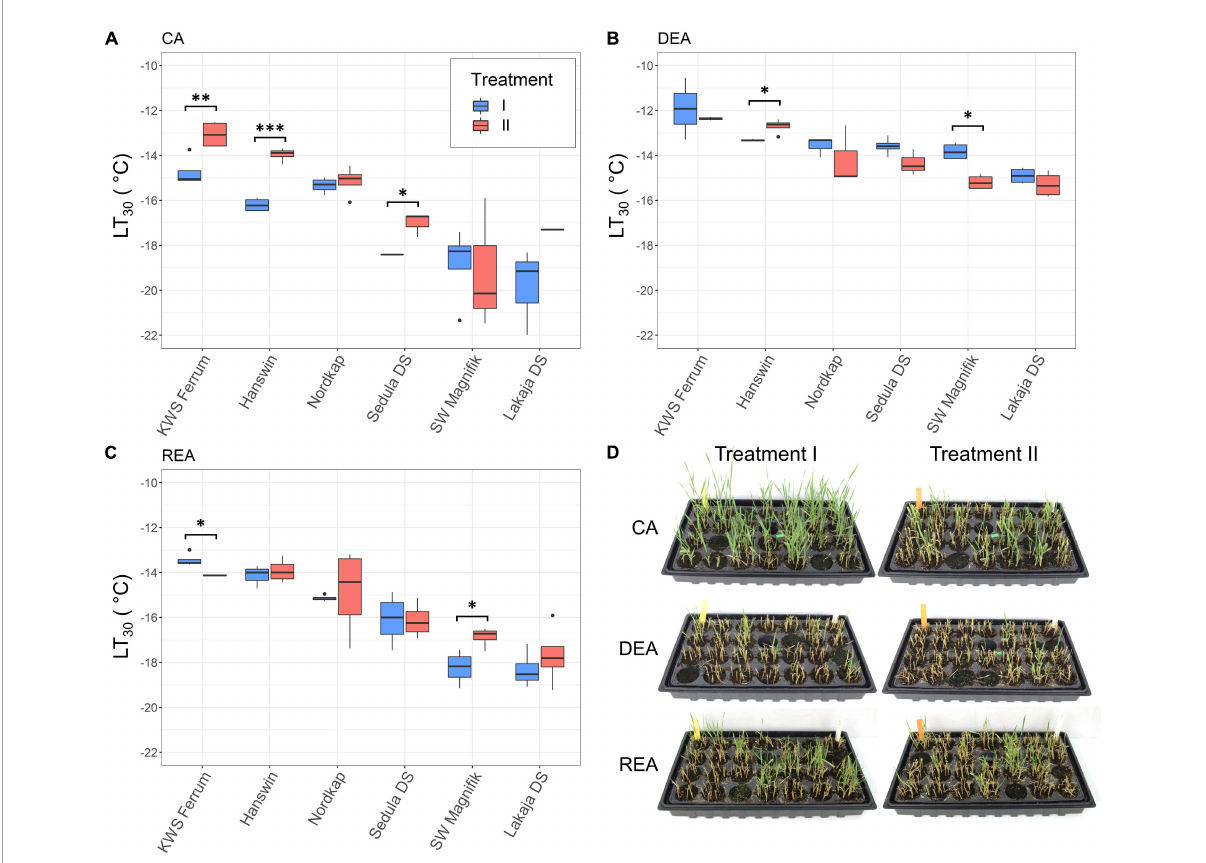
FIGURE3 The effect of different low-temperature treatments during CA on FT of 6 winter wheat genotypes at stages of CA (A) , DEA (B) , and REA (C) . In treatment I, the plants were subjected to constant CA at 2 ◦ C for 49 days, while in treatment II the plants went through CA at 10 ◦ C for 28 days, followed by 2 ◦ C for 21 days. Images of winter wheat, regrown after –16 ◦ C freezing tests, at stages of CA, DEA and REA (D) ∗ indicates significant differences at p < 0.05, ∗∗ at p < 0.01, and ∗∗∗ at p <